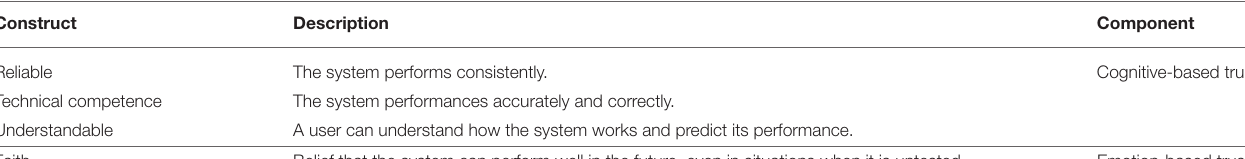
TABLE 2 | The descriptions of each construct measured in our trust